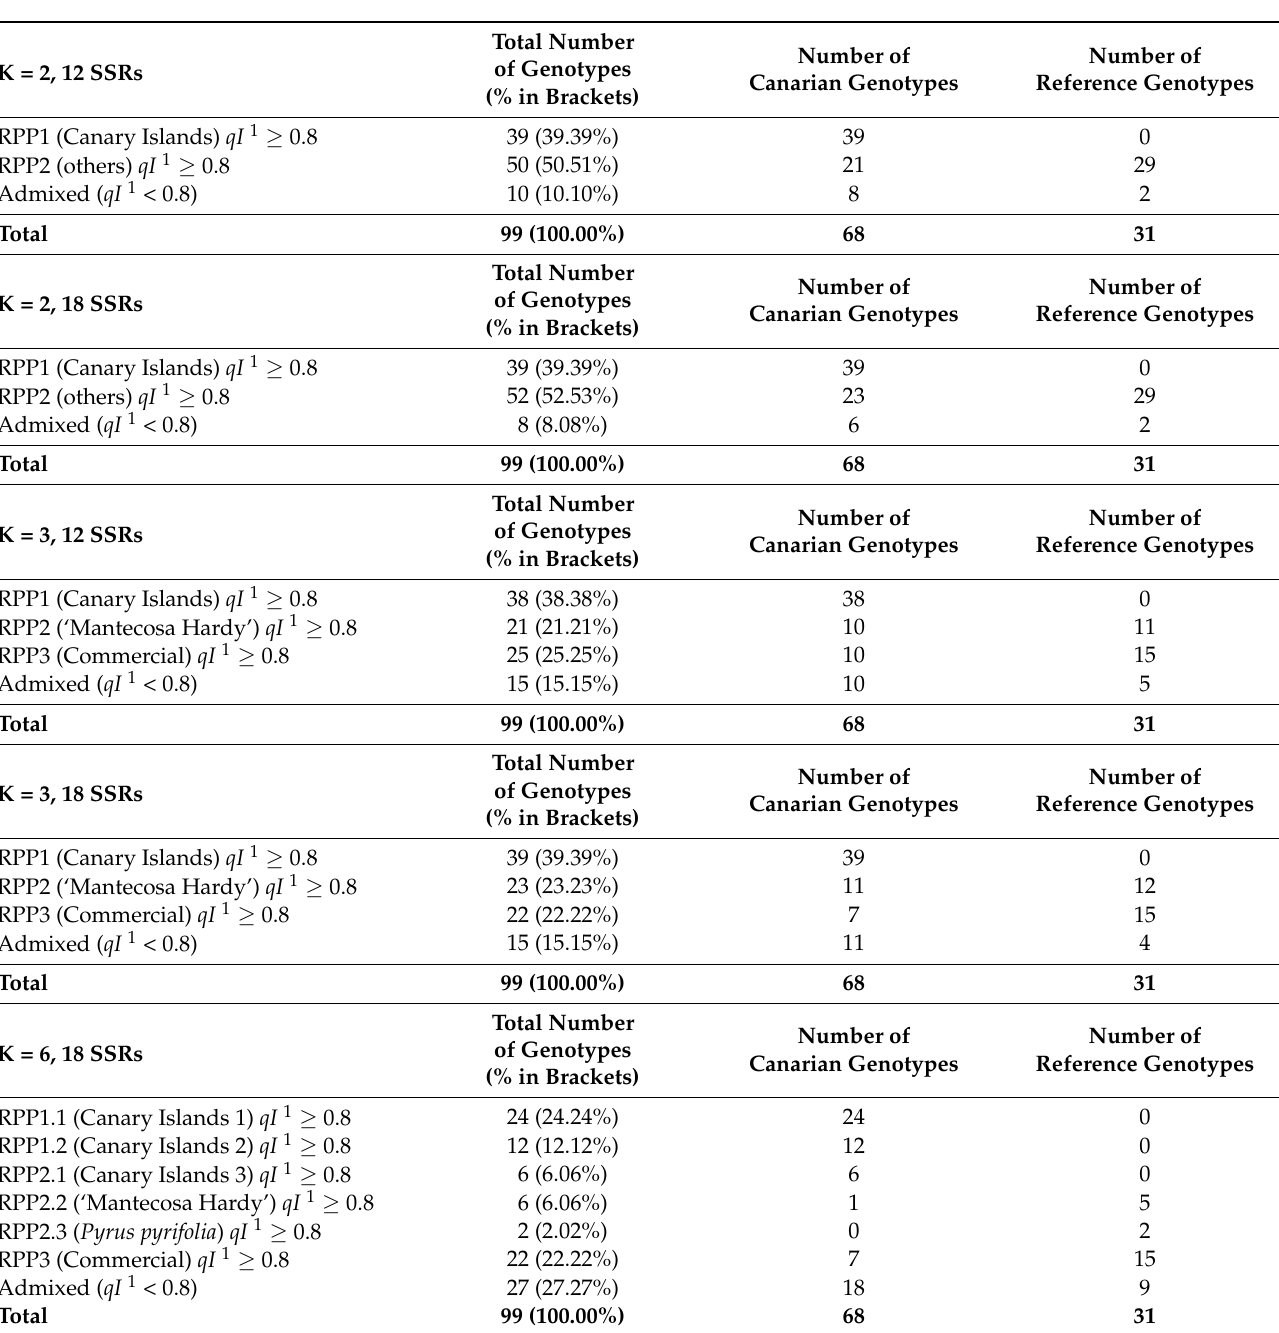
Table 4. Classification of 99 diploid pear genotypes for K = 2, K = 3 and K = 4 reconstructed populations (RPPs) according to STRUCTURE [35] for the Canary Islands genotypes and the reference commercial